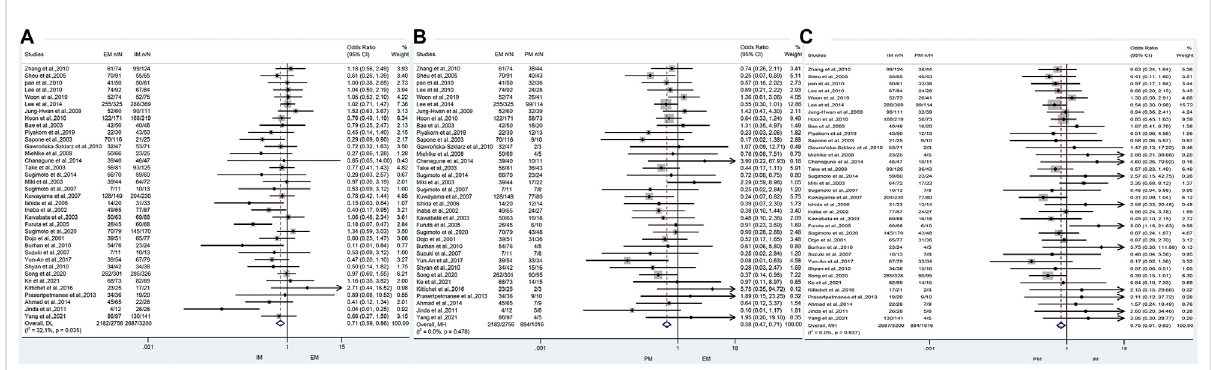
FIGURE 3 (A) Forest plot of EM vs. PM in relation to the H. pylori cure rate in the CYP2C19 genotype ( p = 0.035). (B) Forest plot of EM vs. PM in relation to the H.pylori curerateintheCYP2C19 genotype ( p =0.478). (C) ForestplotofIMvs.PMinrelationtothe H.pylori curerateintheCYP2C19 genotype ( p = 0.537). p = 0.05, signi fi cant heterogeneity, or statistically signi fi cant, when appropriate. p < 0.05, random-effects model; p > 0.05, random- effects model. Symbol: , single studies included in the meta-analysis; , sample size of single studies;